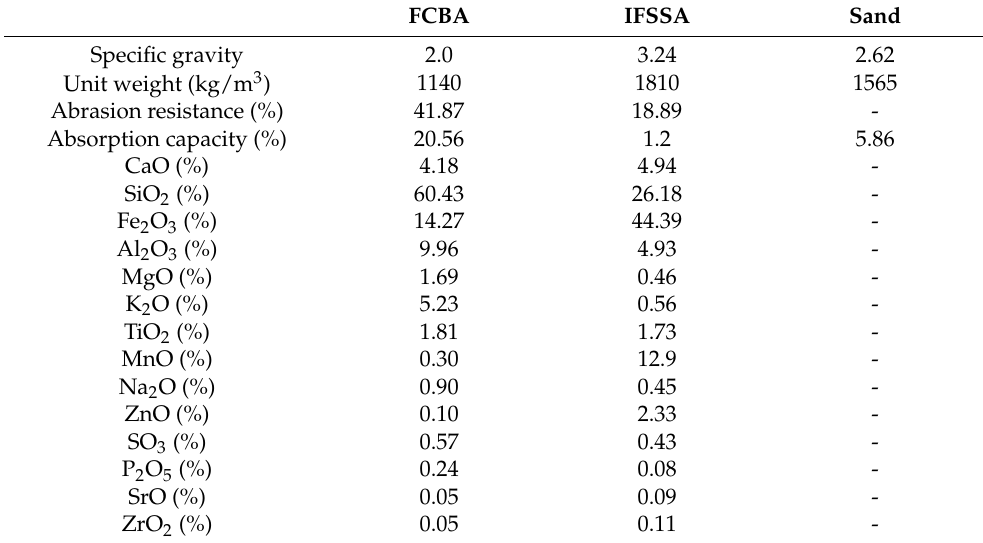
Table 1. Physical and chemical properties of aggregates.